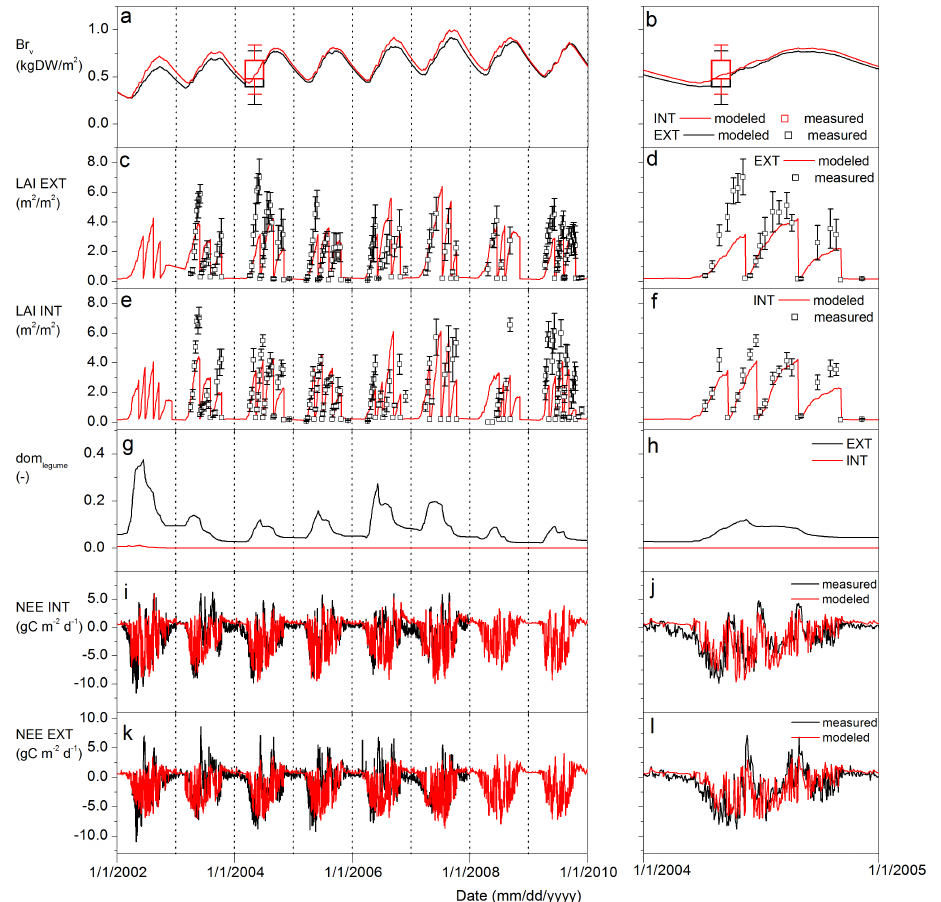
Fig. 3. Simulation and measurement results for grassland at Oensingen under extensive management (EXT) and intensive management (INT) at multi-annual (left panels) and annual (right panels) time scales. (a, b) measured and modeled sum of root biomass (Br, vertical bars indicate ± se); (c–f) measured and modeled LAI; (g, h) dominance of leguminous species in terms of foliage cover (dom modeled net ecosystem exchange (NEE). Corresponding performance criteria are shown in Table